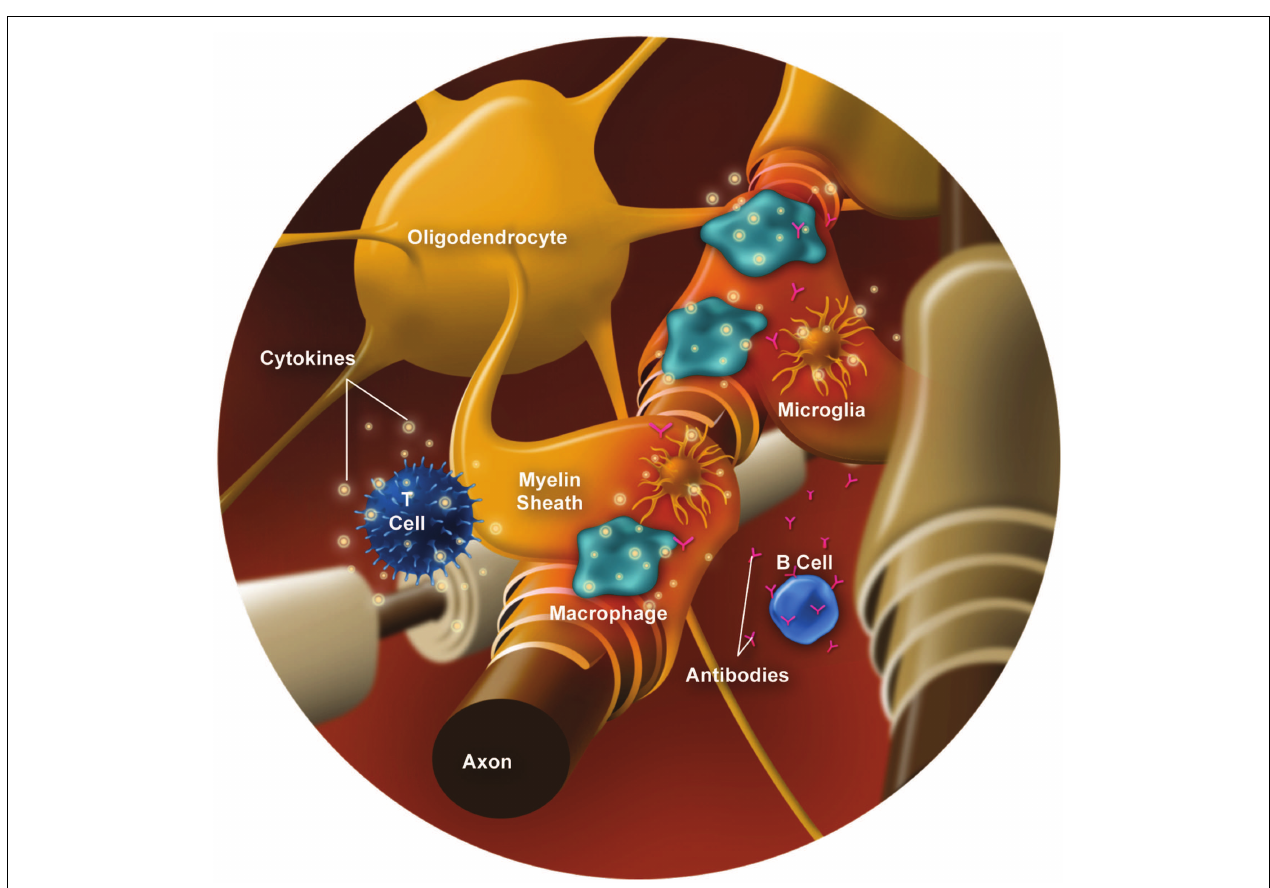
FIGURE 1 | Cells and inflammatory mediators involved in